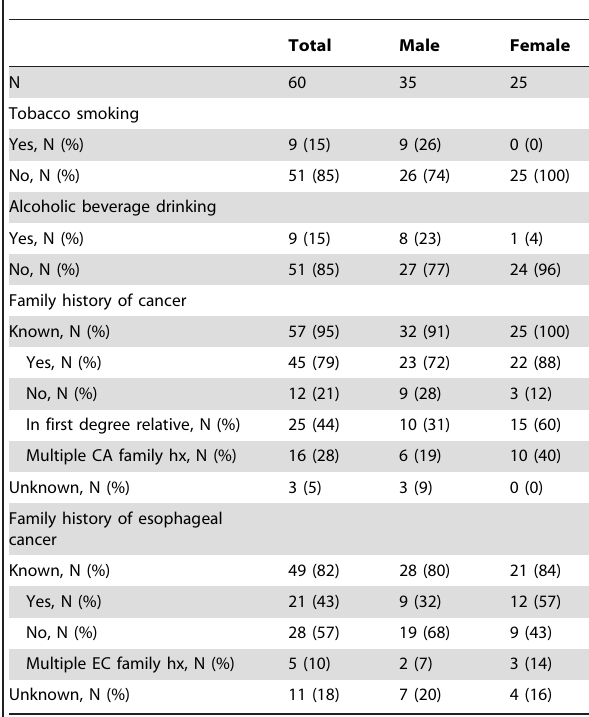
Table 3 . Distributions of risk factors overall and by sex for esophageal cancer among patients # 30 years of age seen